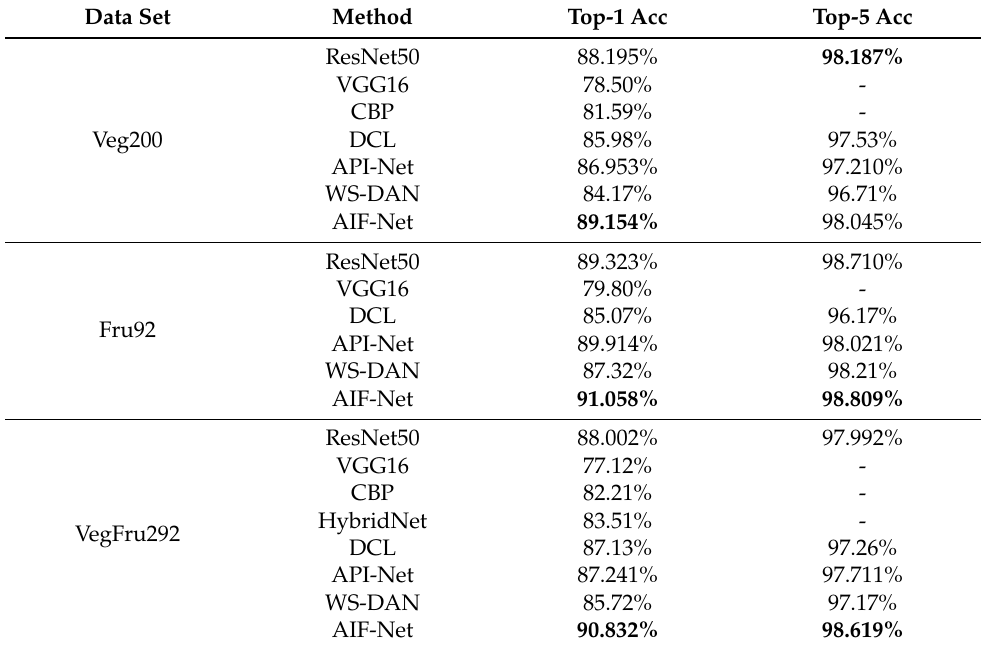
Table 3. A performance comparison of all models. The highest score of each metric is marked in